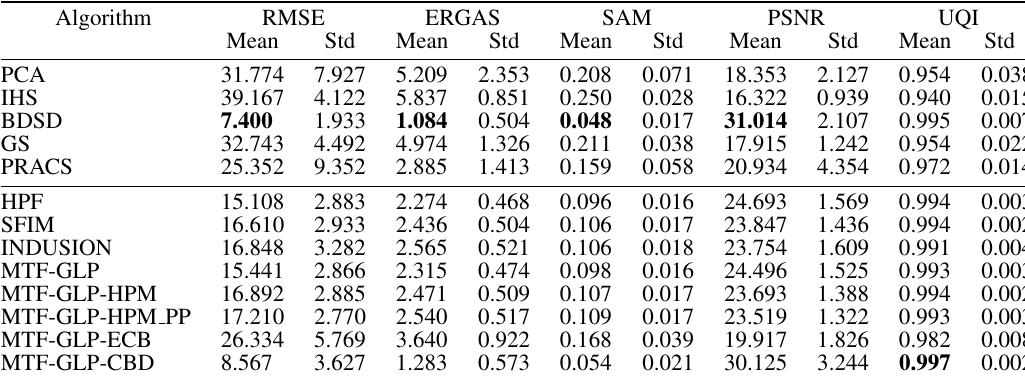
Table 4. Quality indices for the raw band grayscale Thermal Pansharpened images from the Illescas UAV dataset for each